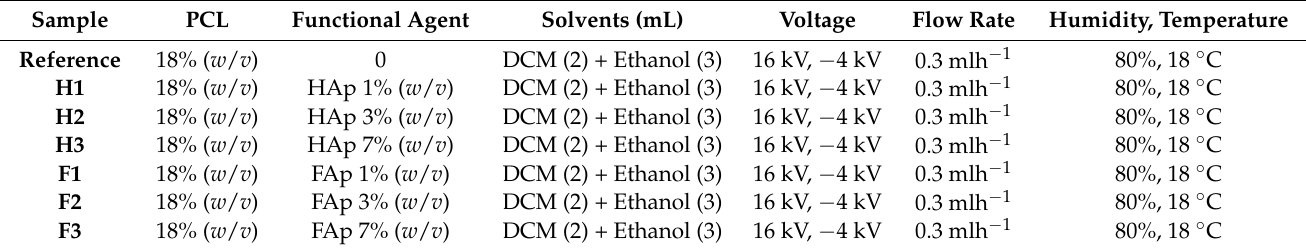
Table 1. Description of solutions and parameters used for